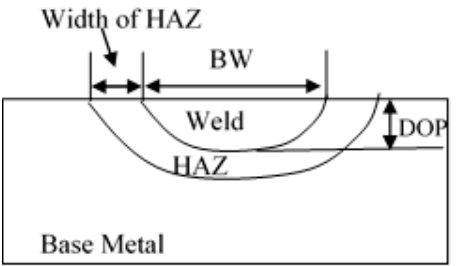
Figure 2. Weld bead morphological dimensions: width of Heat-Affected Zone (HAZ), Bead Width (BW), Depth of Penetration (DOP). Table 5. Experimentally measured values.